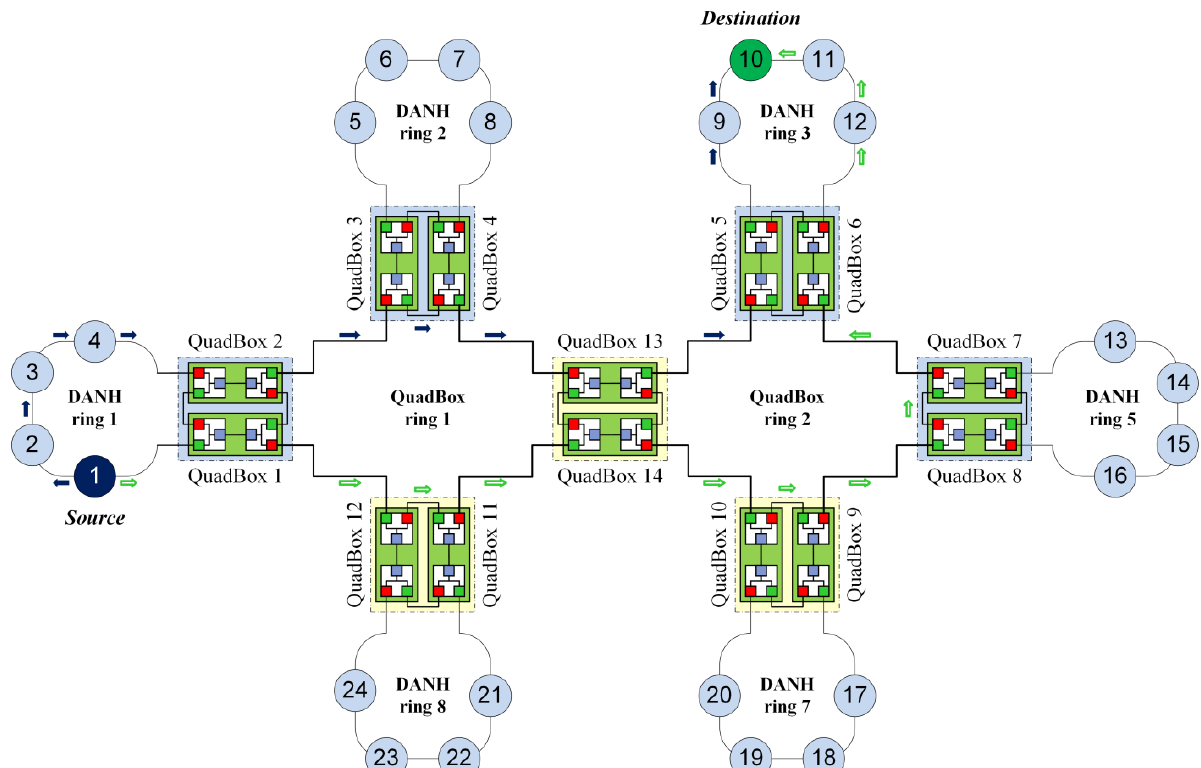
Figure 14. Forwarding unicast traffic under the ODP